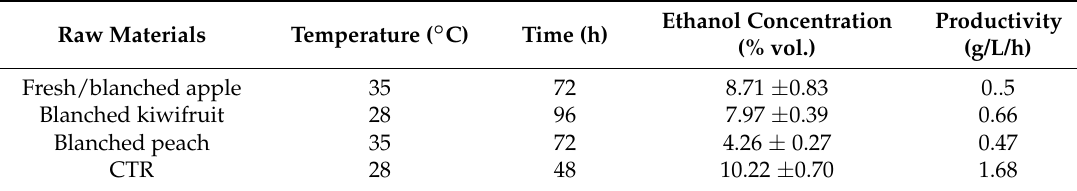
Table 3. Selection of best results from batch fermentations.